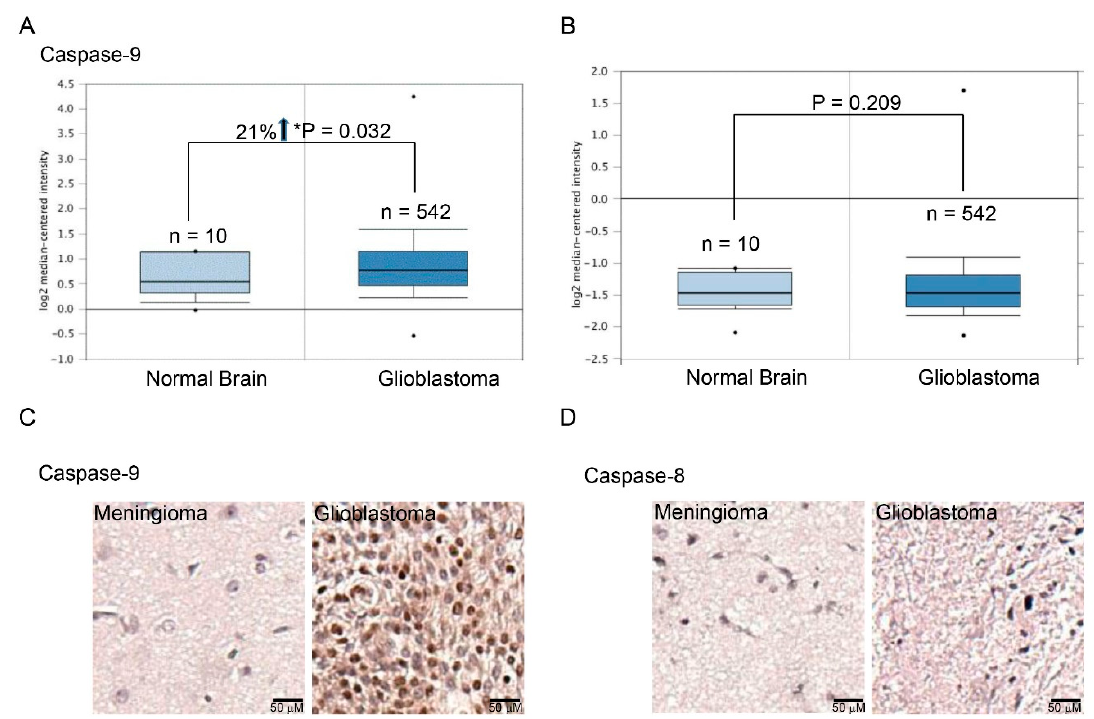
Figure 1. Differential expressions of caspase-9 and -8 mRNAs and proteins in human control brain tissues and glioblastomas. Expressions of caspase-9 ( A ) and caspase-8 mRNAs ( B ) were mined in the cancer genome atlas (TCGA) database. Immunohistological analyses of caspase-9 ( C ) and caspase-8 ( D ) in human meningioma and glioblastoma tissues were further carried out. There were six meningioma and glioblastoma patients checked. The representative images are shown. The symbol * indicates that the value significantly differs from the normal brain group, p < 0.05.